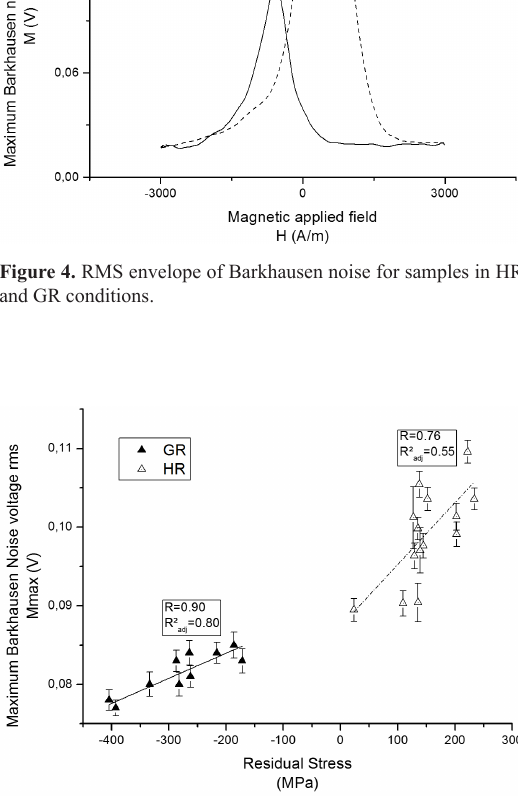
Figure 5. Correlation between XRD measured residual stress values and amplitude of the RMS of Barkhausen noise signals at each point on samples HR and GR.